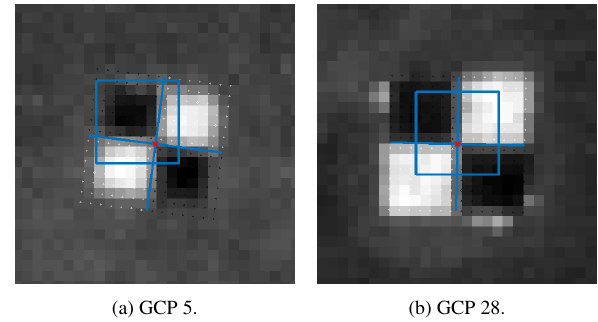
(a) GCP 5. (b) GCP 28. Figure 7. Examples of automated GCPs measurements in ign6xl flight, 30 × 30 pixels crops, depth 120